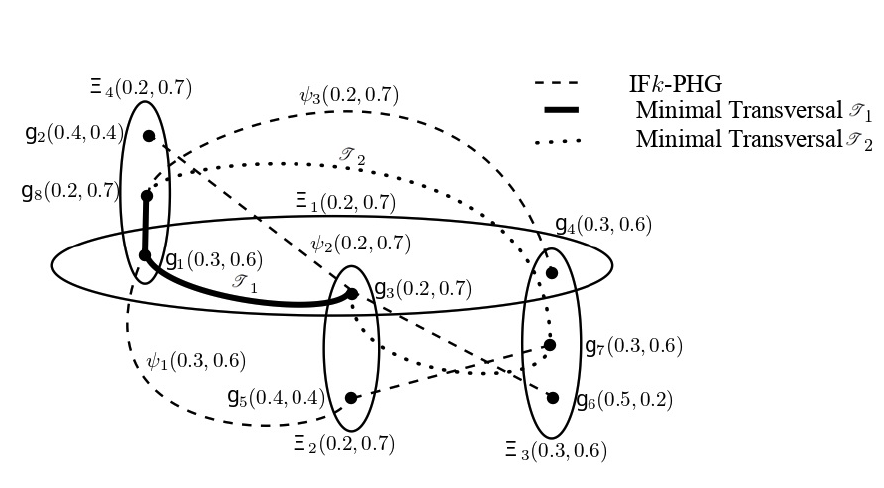
Figure 2: ℵ and minimal IFT of